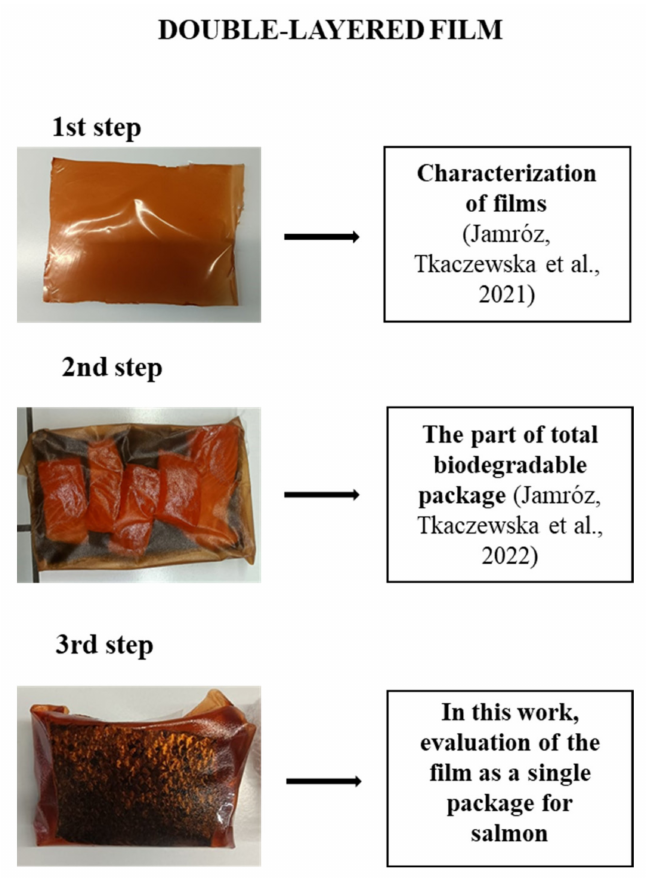
Figure 2. The use of double-layer films as packaging materials